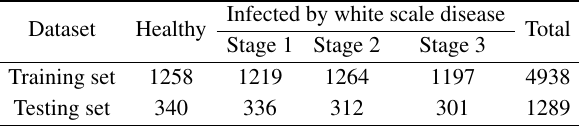
Fig. 5 Distribution of images per class. Table 1 Distribution of samples in the training set and testing